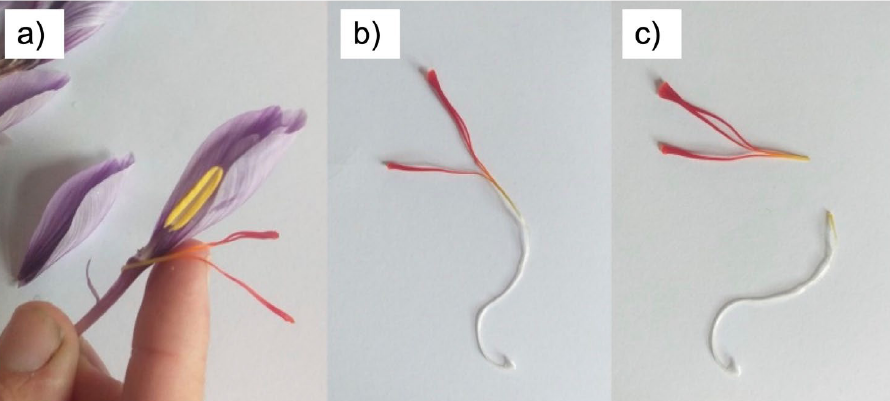
Fig. 2: The manual/traditional process of cleaning saffron (“ mondatura ”): entire saffron flower (a), saffron stigmas and stylus (b), stigmas removed from the stylus (c).